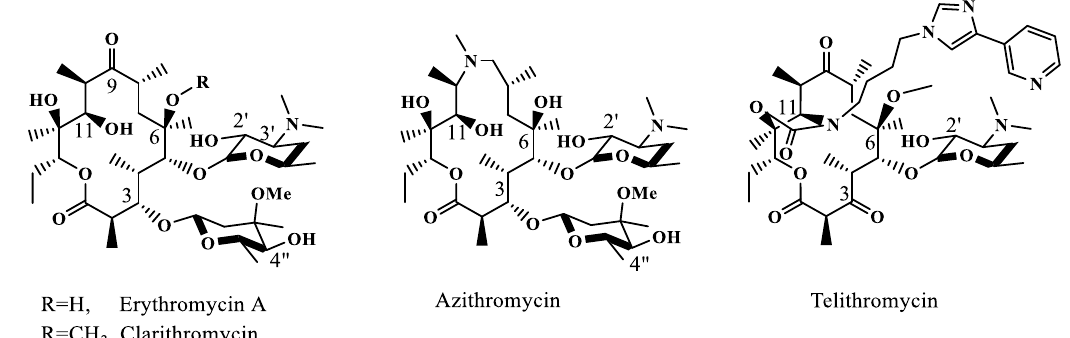
Figure 1. Structures of the 1st-, 2nd- and 3rd-generation erythromycin.